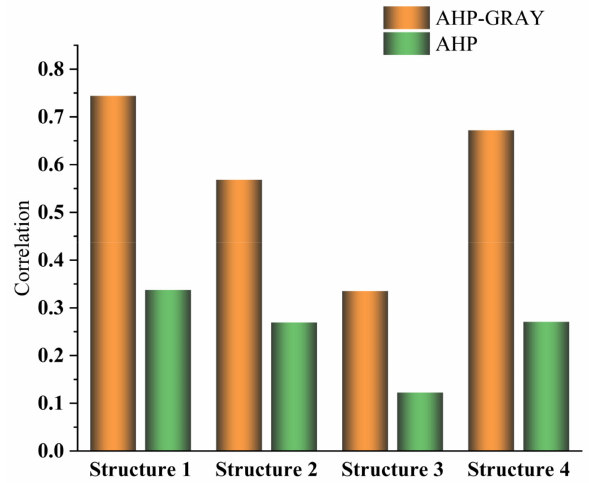
Figure 10. Comparison of correlation results between AHP and improved AHP.